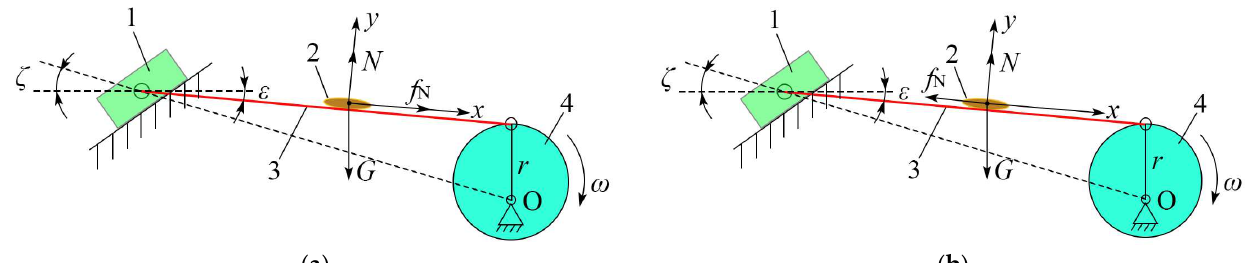
Figure 9. Kinematic model of a vibrating screen: ( a ) Slip-on detachment. ( b ) Slippage of debris. (1) limit slider. (2) Flaxseed grain. (3) Sieve surface. (4) Eccentric wheel. Note: G is the gravity of the